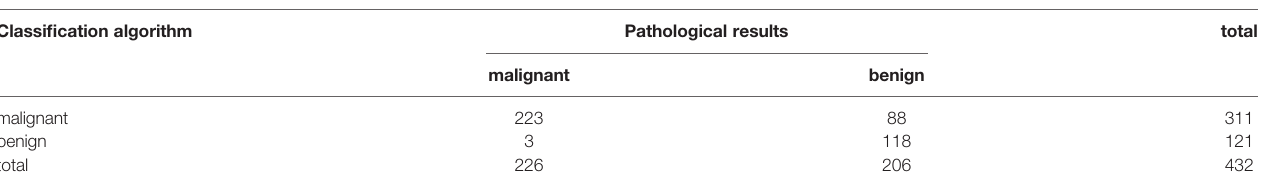
TABLE 5 | Comparison of classi fi cation algorithm and pathological results. Classi fi cation